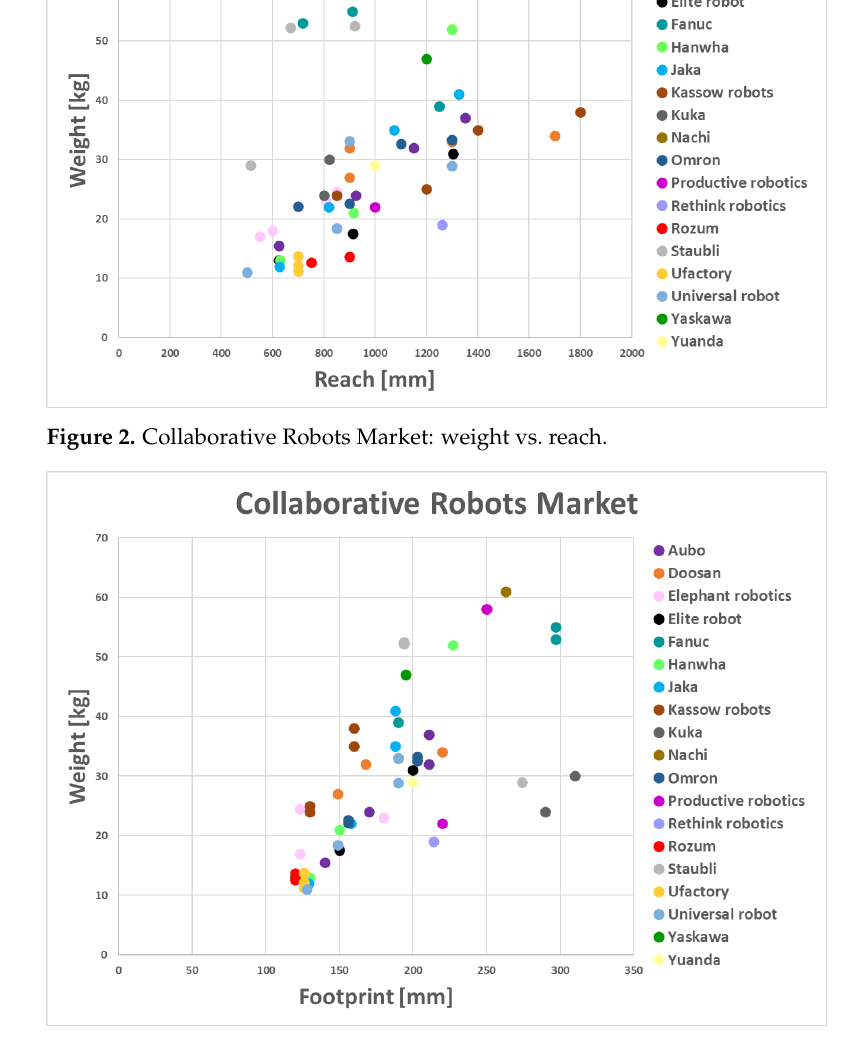
Figure 3. Collaborative Robots Market: weight vs.